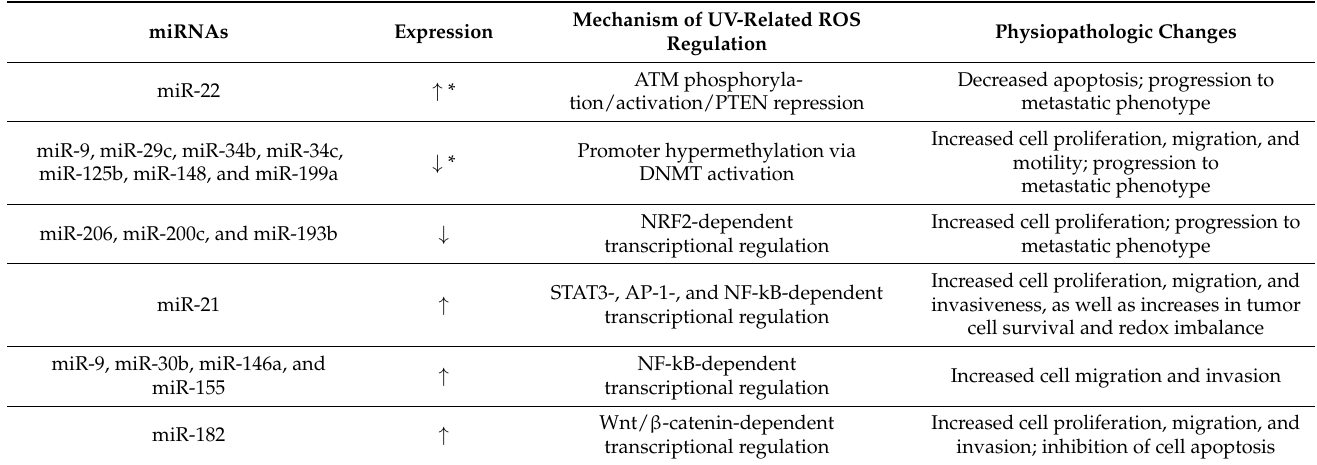
Table 2. Expression, mechanisms of regulation, and physiopathologic consequences of UV-induced, redox-sensitive miRNAs involved in